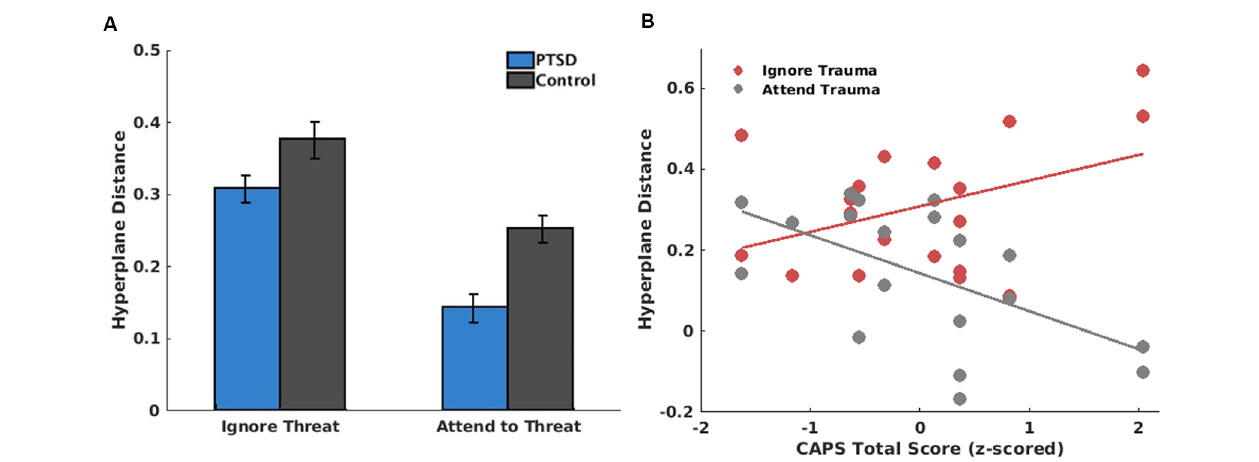
FIGURE 6 | (A) Comparison of β coefficients for brain state regulation between groups as a function of task instruction. β coefficients come from generalized linear models (GLMs) in which HDs (i.e., SVM model predictions) were regressed onto the task design matrix. A higher β coefficient indicates better brain state regulation (i.e., the participant increased or decreased the brain state following task instructions). (B) Scatter plot indicating a significant PTSD symptom severity (CAPS total score) × task instruction interaction on β coefficients among the PTSD participants. As can be seen, more severe PTSD symptoms were associated with better brain state regulation when the task instruction was consistent with avoidance (i.e., ignore trauma words), yet worse brain state regulation when the task instruction asked participants to attend to the trauma words.